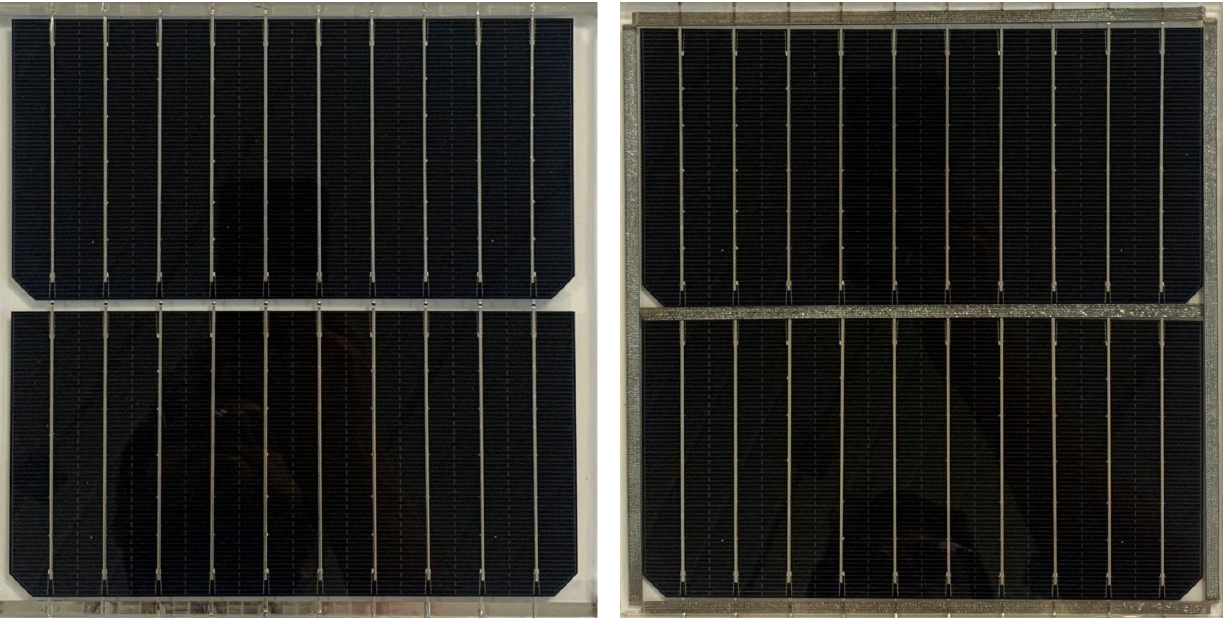
Figure 15. ( Left )—modified module #1, ( right )—modified module